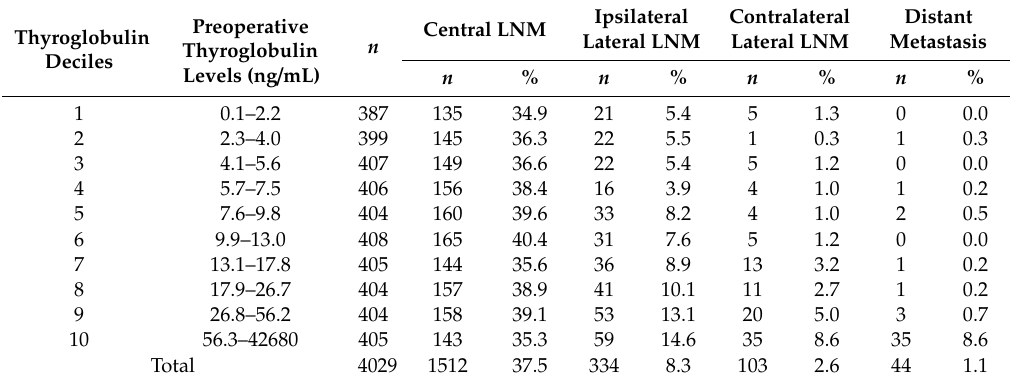
Figure 2. Correlation between tumor extent and preoperative thyroglobulin levels. Tumor extent was classified as (1) no lymph node metastases (LNM), (2) central LNM, (3) ipsilateral lateral LNM, (4) contralateral lateral LNM, and (5) distant metastasis. We found a linear association between the proportion of patients with higher tumor extent and increasing preoperative serum thyroglobulin levels. Thyroglobulin deciles: the deciles of patients with different levels of preoperative thyroglobulin levels (levels increase from 1 to 10). Table 4. Tumor extent by preoperative serum thyroglobulin levels.